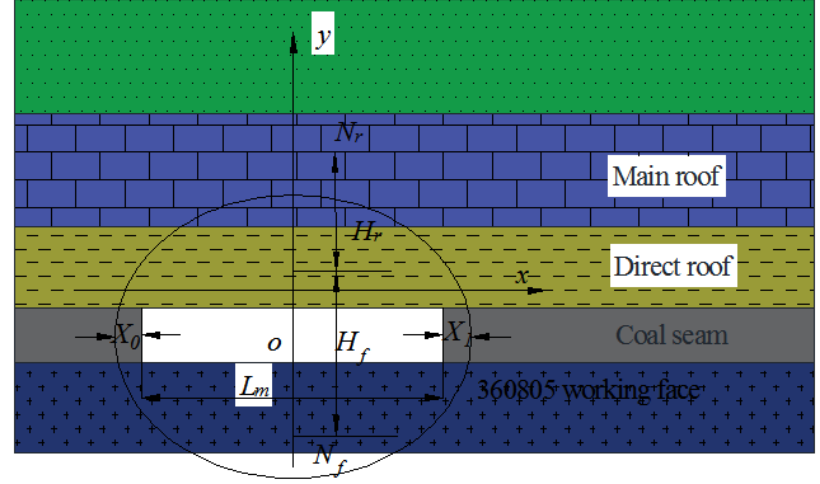
Figure 3. Strike section along 360,805 working face.